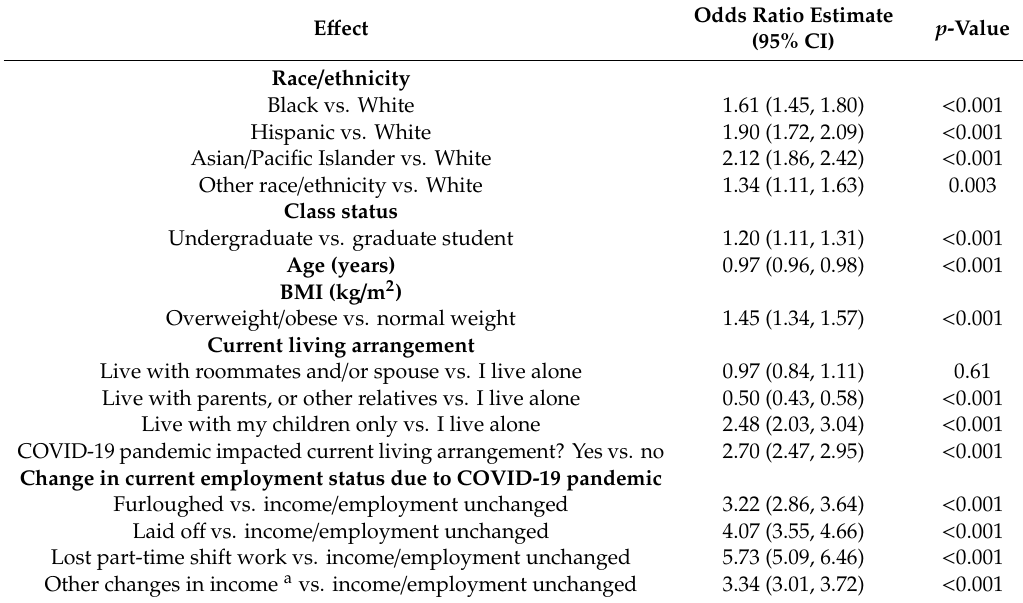
Table 5. Predictors of food insecurity during the COVID-19 pandemic.